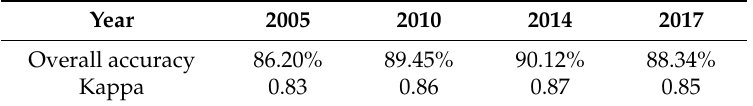
Table 3. Classification accuracy